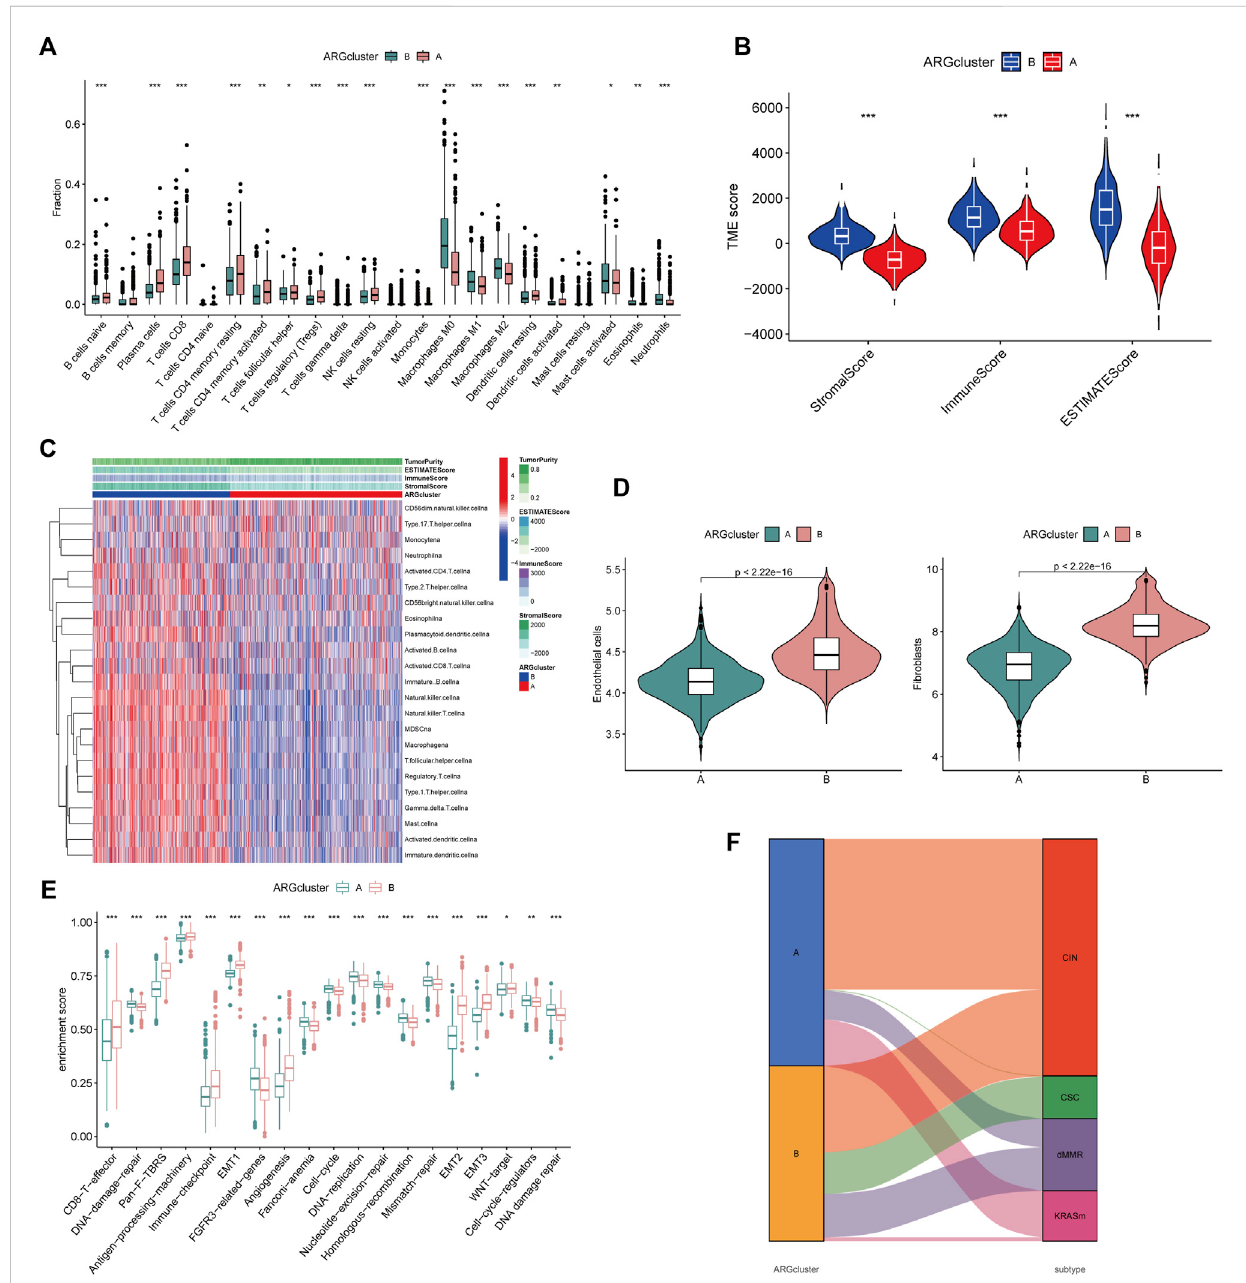
FIGURE 3 Differential TME characteristics (A) The proportion of immune cell in fi ltration in the two angiogenesis clusters was calculated using the CIBERSORT algorithm. The upper and lower ends of the boxes represented interquartile range of values. The lines in the boxes represented median value, and black dots showed outliers. The asterisks represented the statistical p -value (* p < 0.05; ** p < 0.01; *** p < 0.001). (B) Relationship between TME score and subtypes (* p < 0.05; ** p < 0.01; *** p < 0.001). (C) Heatmap was constructed using ssGSEA to visualize and compare the relative abundance, mesenchymalscore,immunescore,andtumorpurityof23immunein fi ltratingcellsubpopulationsunderdifferentclusters. (D) Differencesinendothelial cells and fi broblasts in different clusters were evaluated using the MCPcounter algorithm. The thick line represented the median value. The bottom and top of the boxes represented interquartile range of values. The whiskers encompassed 1.5 times the interquartile range. The differences between every two groups were compared through the Kruskal-Wallis test (* p < 0.05; ** p < 0.01; *** p < 0.001). (E) Differences in 20 signatures (immune-related signature, DNA repair-related signature, and stroma-related signature) between different clusters. The asterisks represented the statistical p -value (* p < 0.05; ** p < 0.01; *** p < 0.001). (F) Alluvial diagram showed the association of molecular subtypes in different